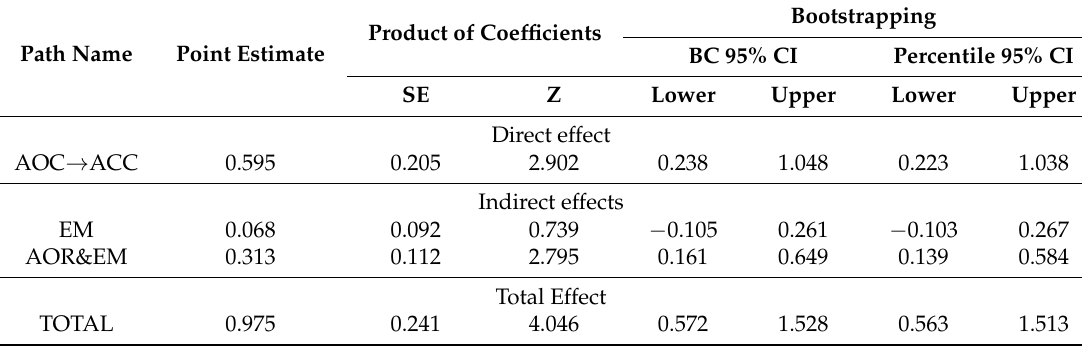
Table 13. Test table of the mediation effect between AOC and